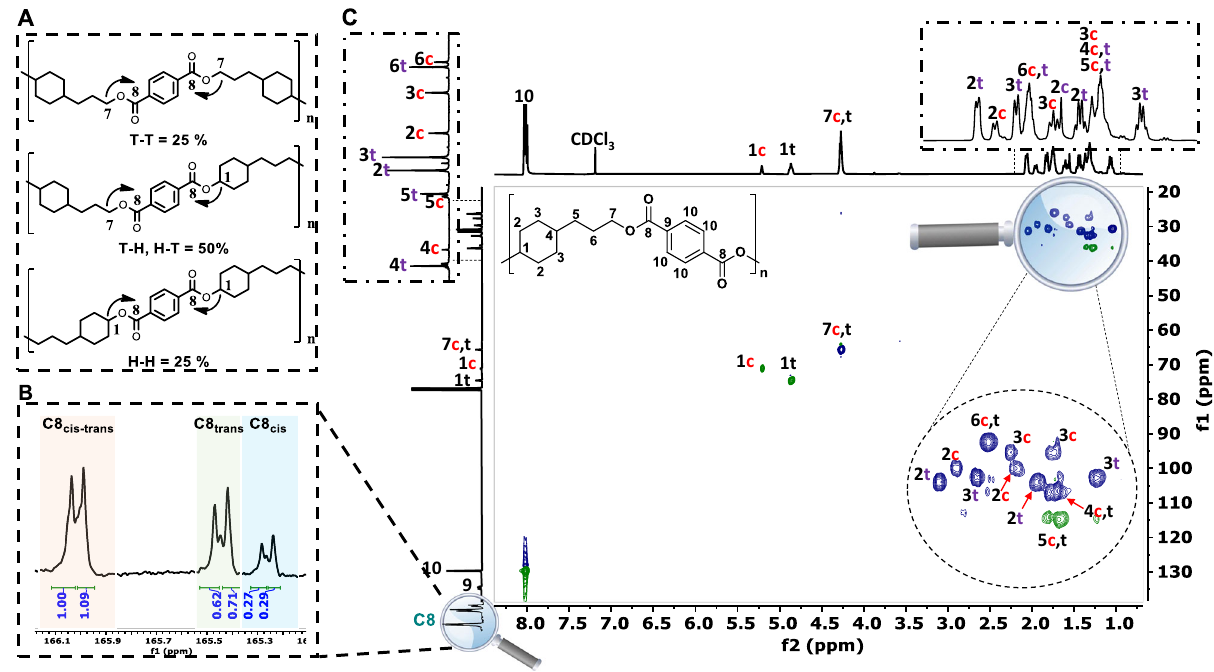
Fig. 4 Structural characterization of poly (PC/TPA) based on NMR spectroscopy. A Proposed unit connectivity of poly (PC/TPA) copolymerized using PC (1: 2 mixture of cis and trans isomers) and DMTA by forming three distinct dyads, namely head-to-tail (H-T), head-to-head (H-H), and tail-to-tail (T-T); B The identi fi cation and quanti fi cation of carbonyl carbon signals (C8) of poly (PC/TPA). Assignment of chemical shifts to the various connectivity units, namely cis, trans, and cis-trans; C 2D-HSQC characterization for the main-chain sequence of poly